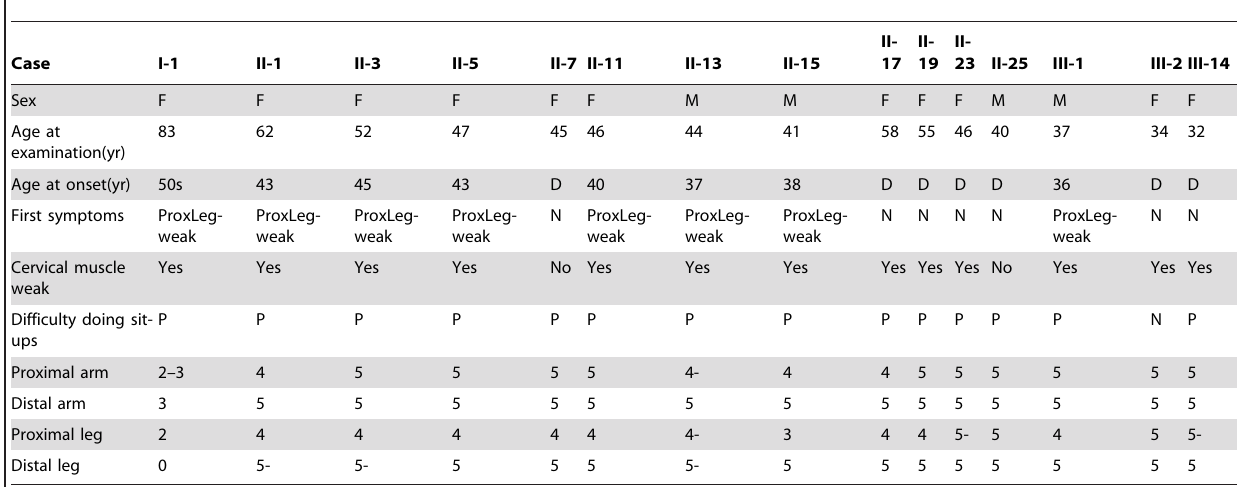
Table 1. Clinical findings in 15 affected individuals with muscle weakness.